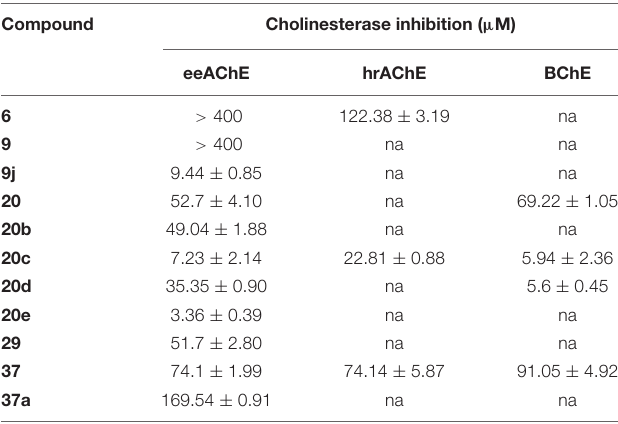
TABLE 1 | Cholinesterase inhibition of lead compounds generated from the virtual